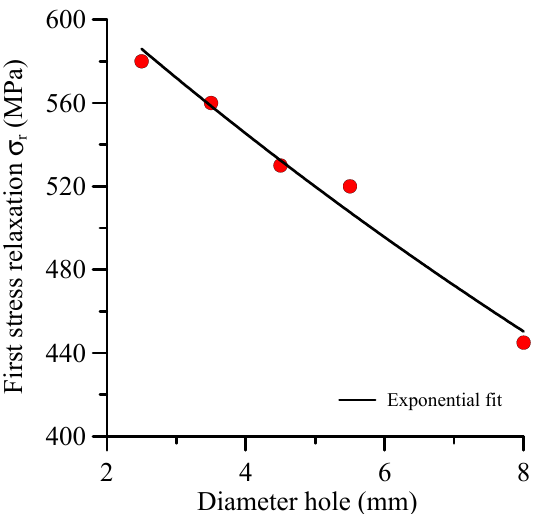
Figure 12. The dependency of σ r with increasing hole diameter.